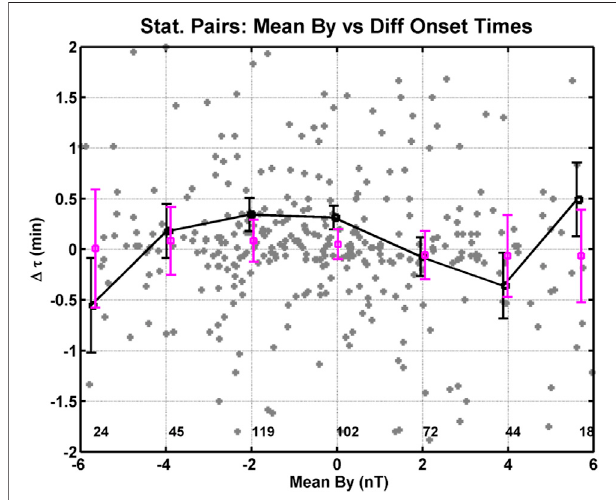
FIGURE 5 | Differences in onset time versus IMF By . The gray points are the individual events, the black points are means of bins 2 nT wide, and the mauvepointsaremediansofbins2 nTwide.Theerrorbarsaretheerrorofthe mean and median. The values at the base of the fi gure indicate the number points per bin.